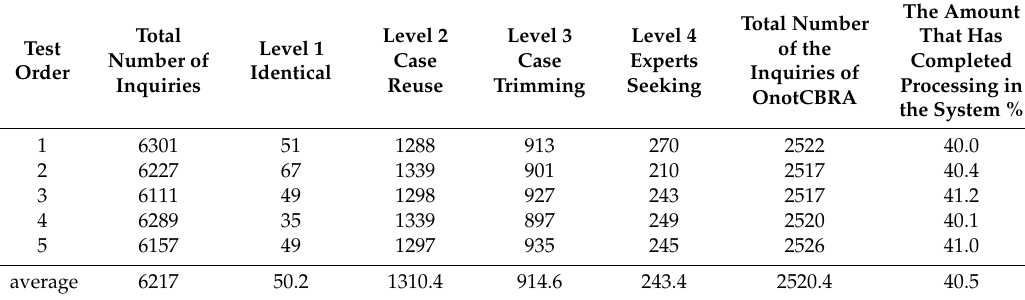
Figure 20. Original system case database. Table 7. Analysis results of performance effectiveness.